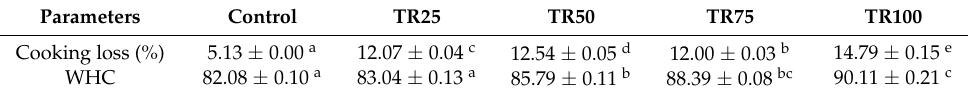
Table 4. Cooking loss and water holding capacity of sausages with pork fat replaced by tremella.